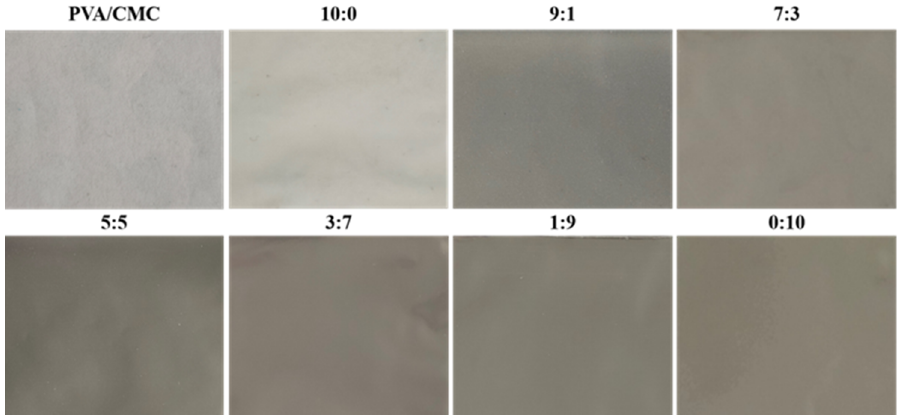
Figure 9. Pictures of the pure PVA/CMC film and the PVA/CMC/ZnO NPs/ x GnP composite film (ultrasonication time, 30 min).